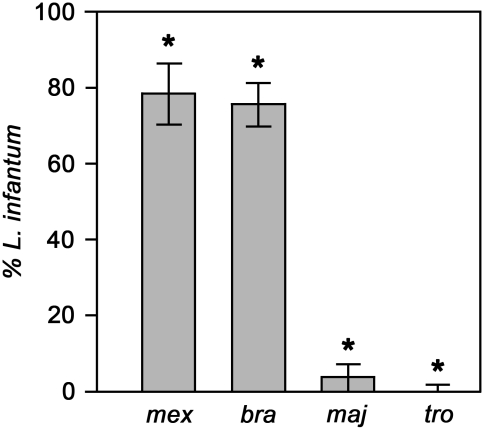
Binding of L. infantum to midguts from Lu. longipalpis in the presence of various Leishmania species (4 experiments).Competing species: mex  =  L. mexicana; bra  =  L. braziliensis; maj  =  L. major; tro  =  L.tropica. Bars represent the mean percentage contribution of L. infantum in the bound population ± S.D. and the asterisks indicate a significant difference to the L. infantum population (>20 dissected guts examined per experiment).